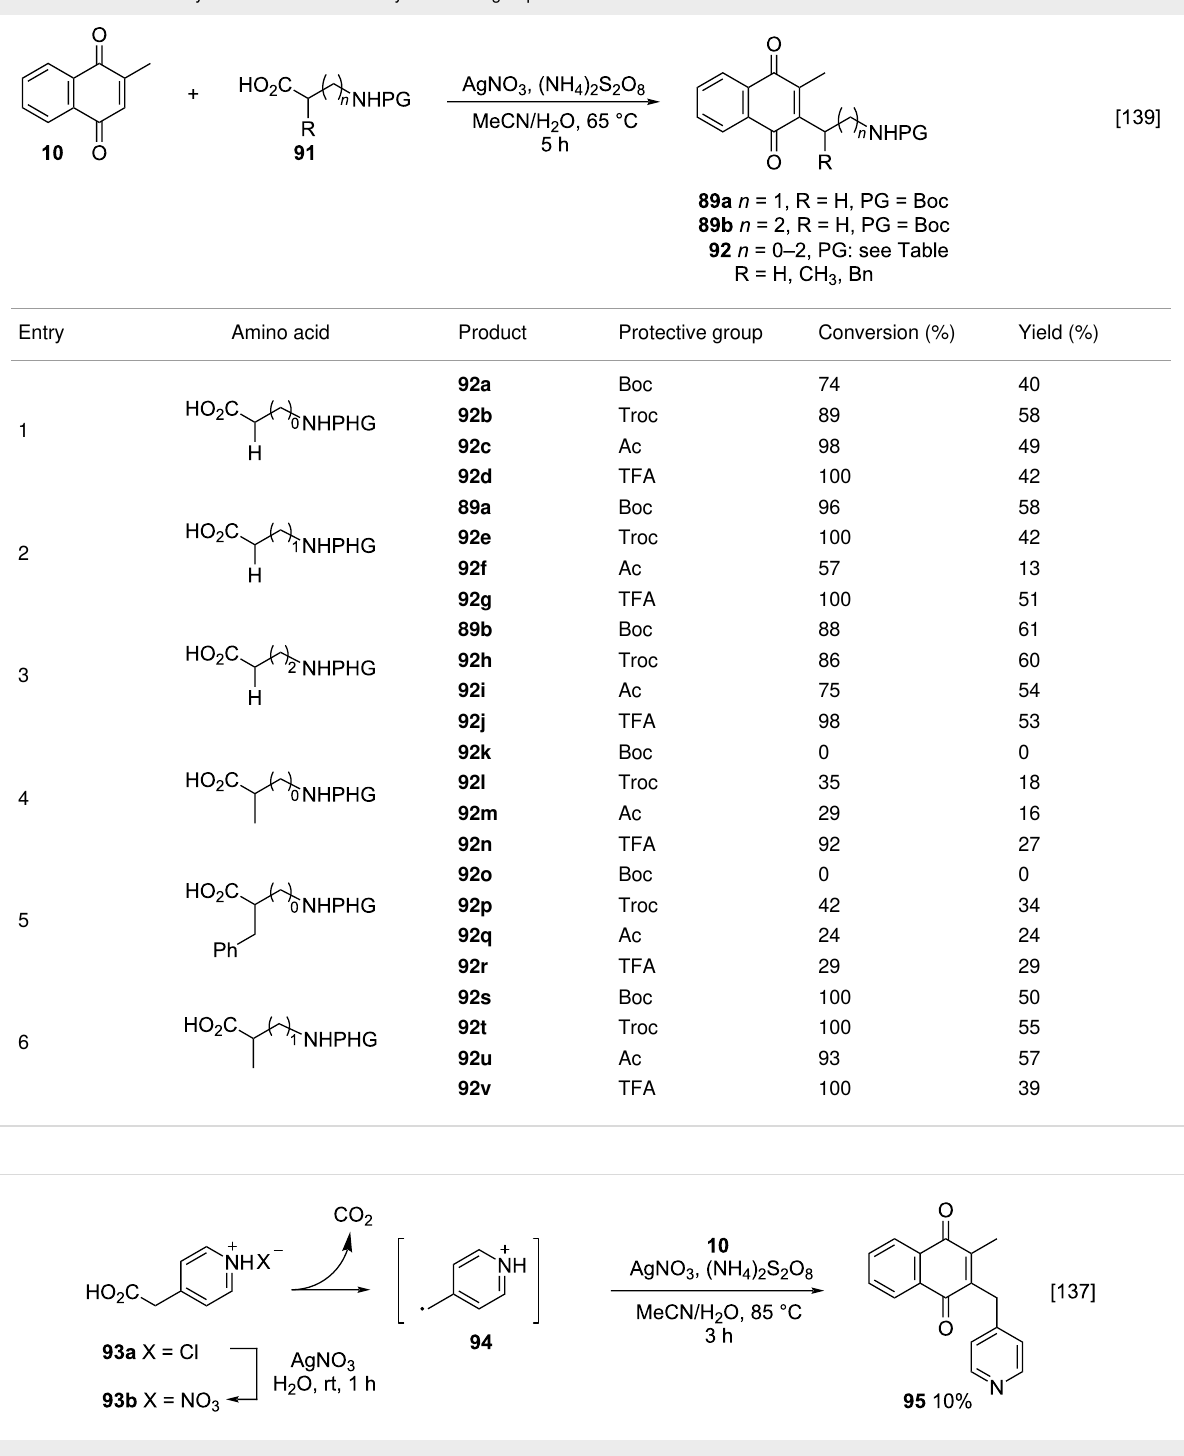
Table 5: Menadione alkylation with amino acids by Naturale’s group.